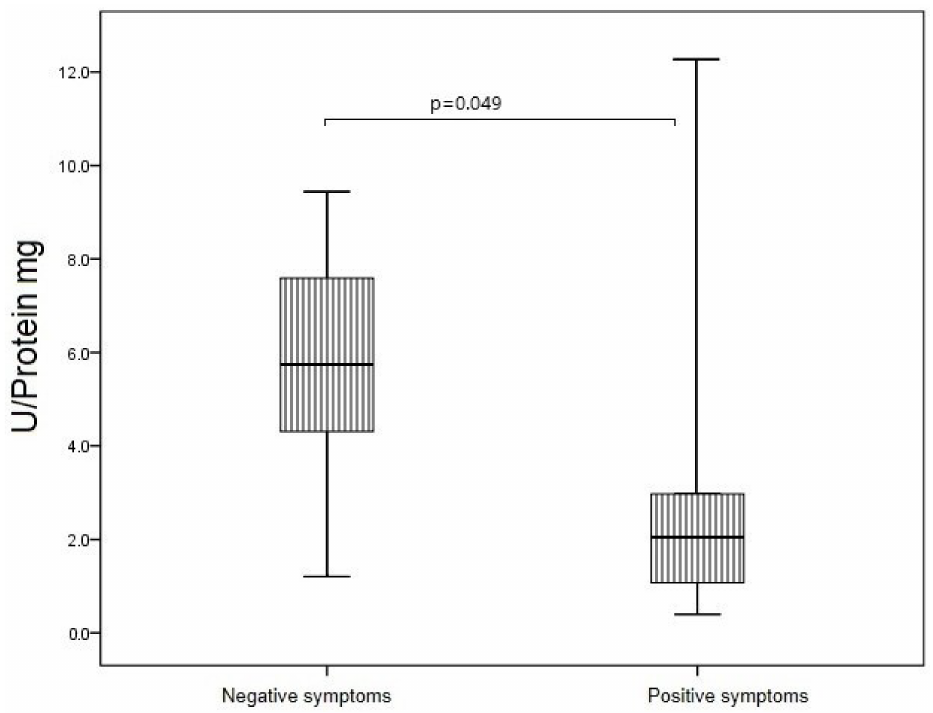
Figure 9. SOD activity of blood erythrocytes in patients with acute schizophrenia depending on the leading symptomology. Note: U corresponds to the amount of enzyme that catalyzes the conversion of 1 µ mol of substrate in 1 min at +25 ◦